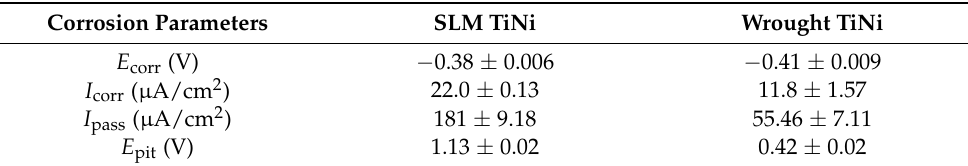
Table 3. Potentiodynamic polarization corrosion parameters of SLM and wrought TiNi samples in 0.5% F − ASS at pH